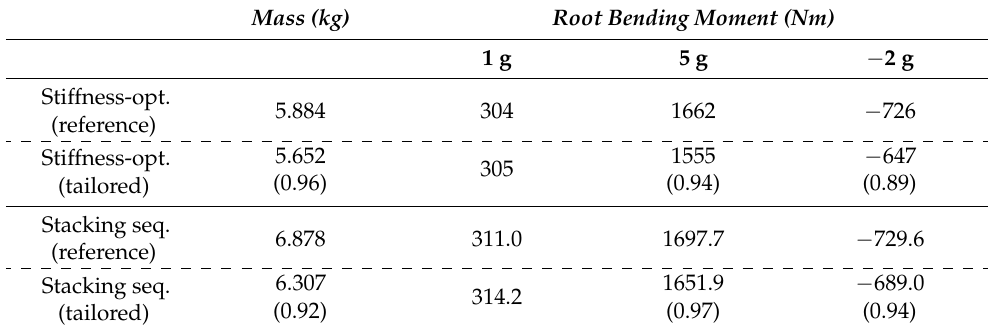
Table 2. Comparison of wing designs from the stiffness optimization step and stacking sequence optimization step: the resulting mass and root bending moments form different manoeuvres (values with respect to the corresponding reference wing denoted within